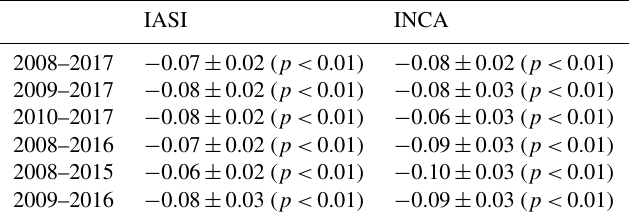
Table B1. Lower free tropospheric O 3 trends (3–6km column) calculated from IASI and INCA for the CEC for different time